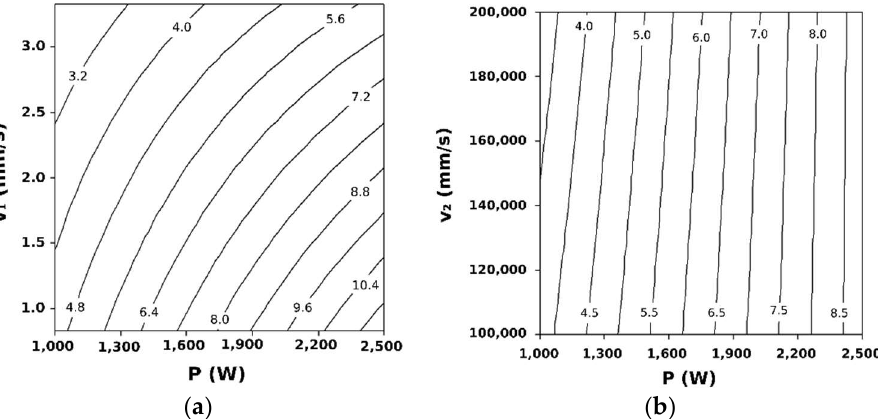
Figure 8. Contour plot of average roughness R a (μm) versus ( a ) laser power ( P ) and transverse speed ( v 1 ), and ( b ) laser power ( P ) and scanning speed ( v 2 ) during the processing of white granite.